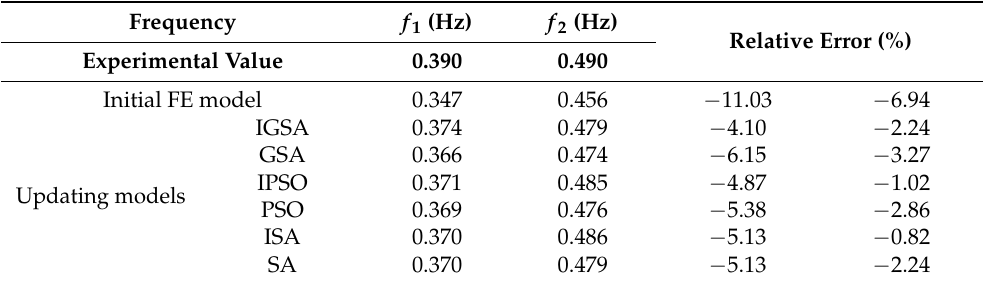
Figure 14. The comparison of the displacement values obtained from experiment (EXP), initial FE model and updated FE models: ( a ) load case A and B; ( b ) load case C and D; and ( c ) load case E and F. Table 9. Comparisons of the frequencies obtained from experiment and the initial FE model and updated FE